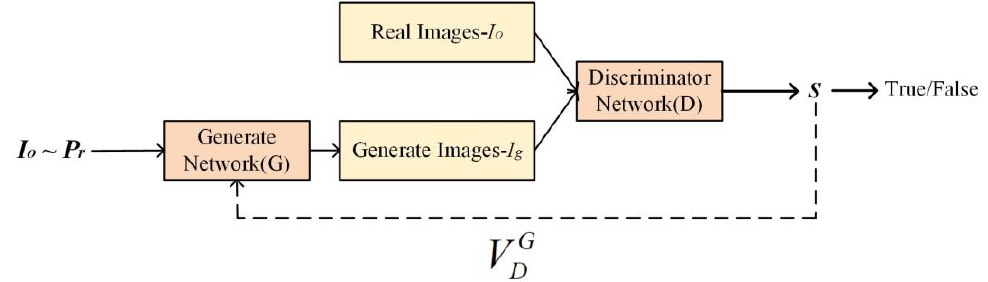
Figure 2. The framework of CFM-GAN.